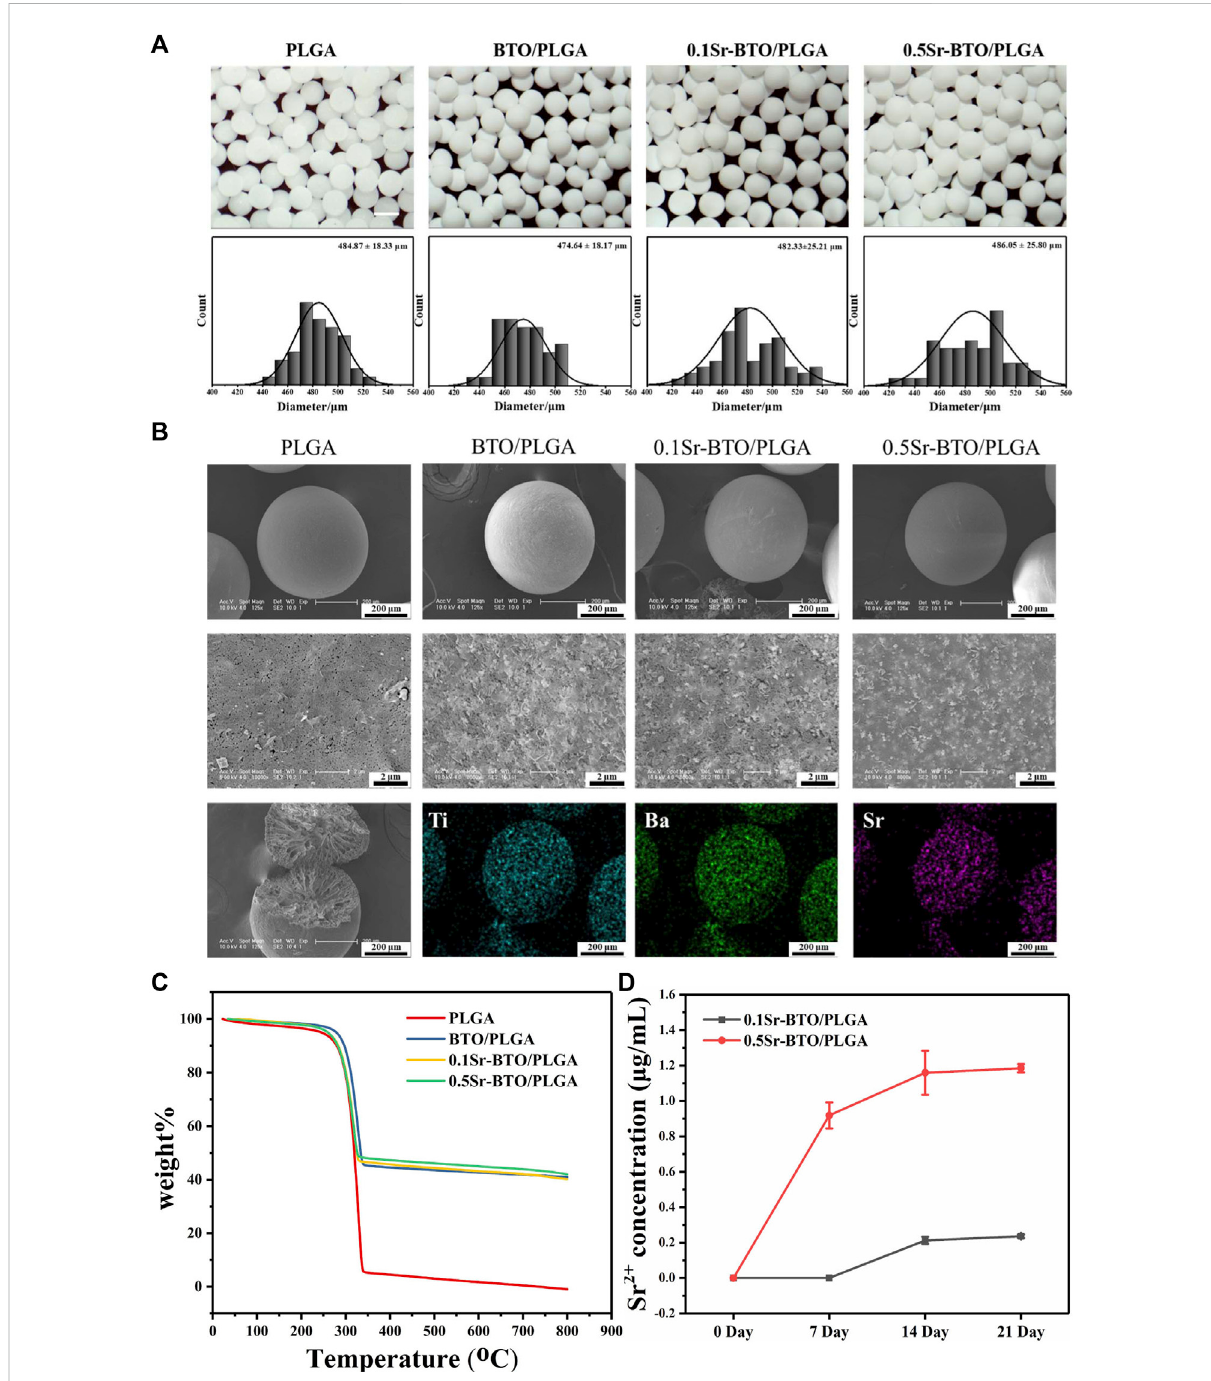
FIGURE 2 (A) Themicrographs and statistical analysisofthesize distributionof microsphere. Scalebar: 500 μ m (B) TheSEM imageand Mapping imageof elemental compositions (including Ti, Ba and Sr elements distribution of 0.1Sr-BTO/PLGA) of microspheres. (C) TGA analysis of Sr-BTO/PLGA microspheres. (D) Sr 2+ release concentration of Sr-BTO/PLGA microspheres immersed in PBS at 0, 7, 14 and 21